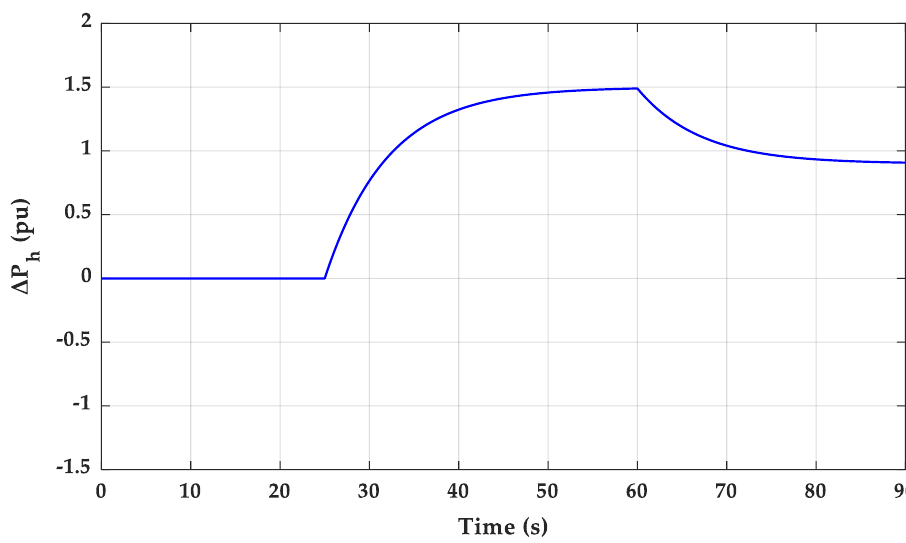
Figure 7. Response of the angular speed deviation of the SGIB with reheating. Energies 2020 , 13 , x FOR PEER REVIEW 20 of 24